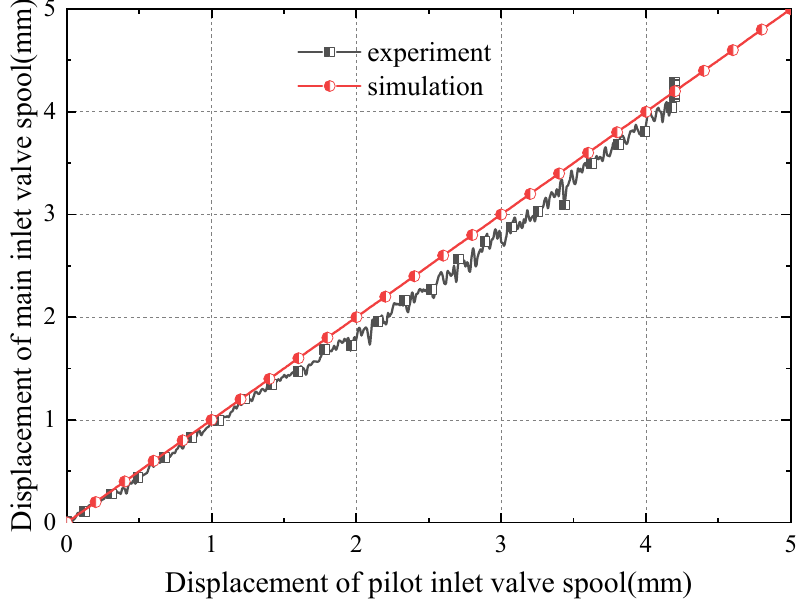
Figure 7. Test results of steady-state control characteristics.